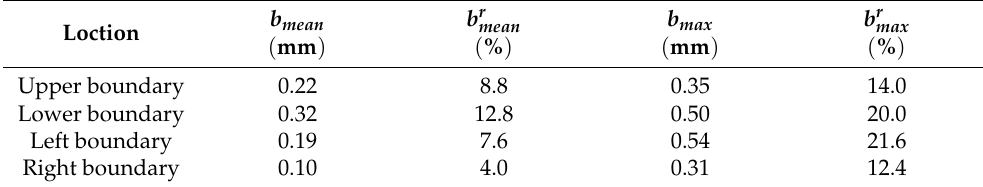
Table 3. The error statistics of the four